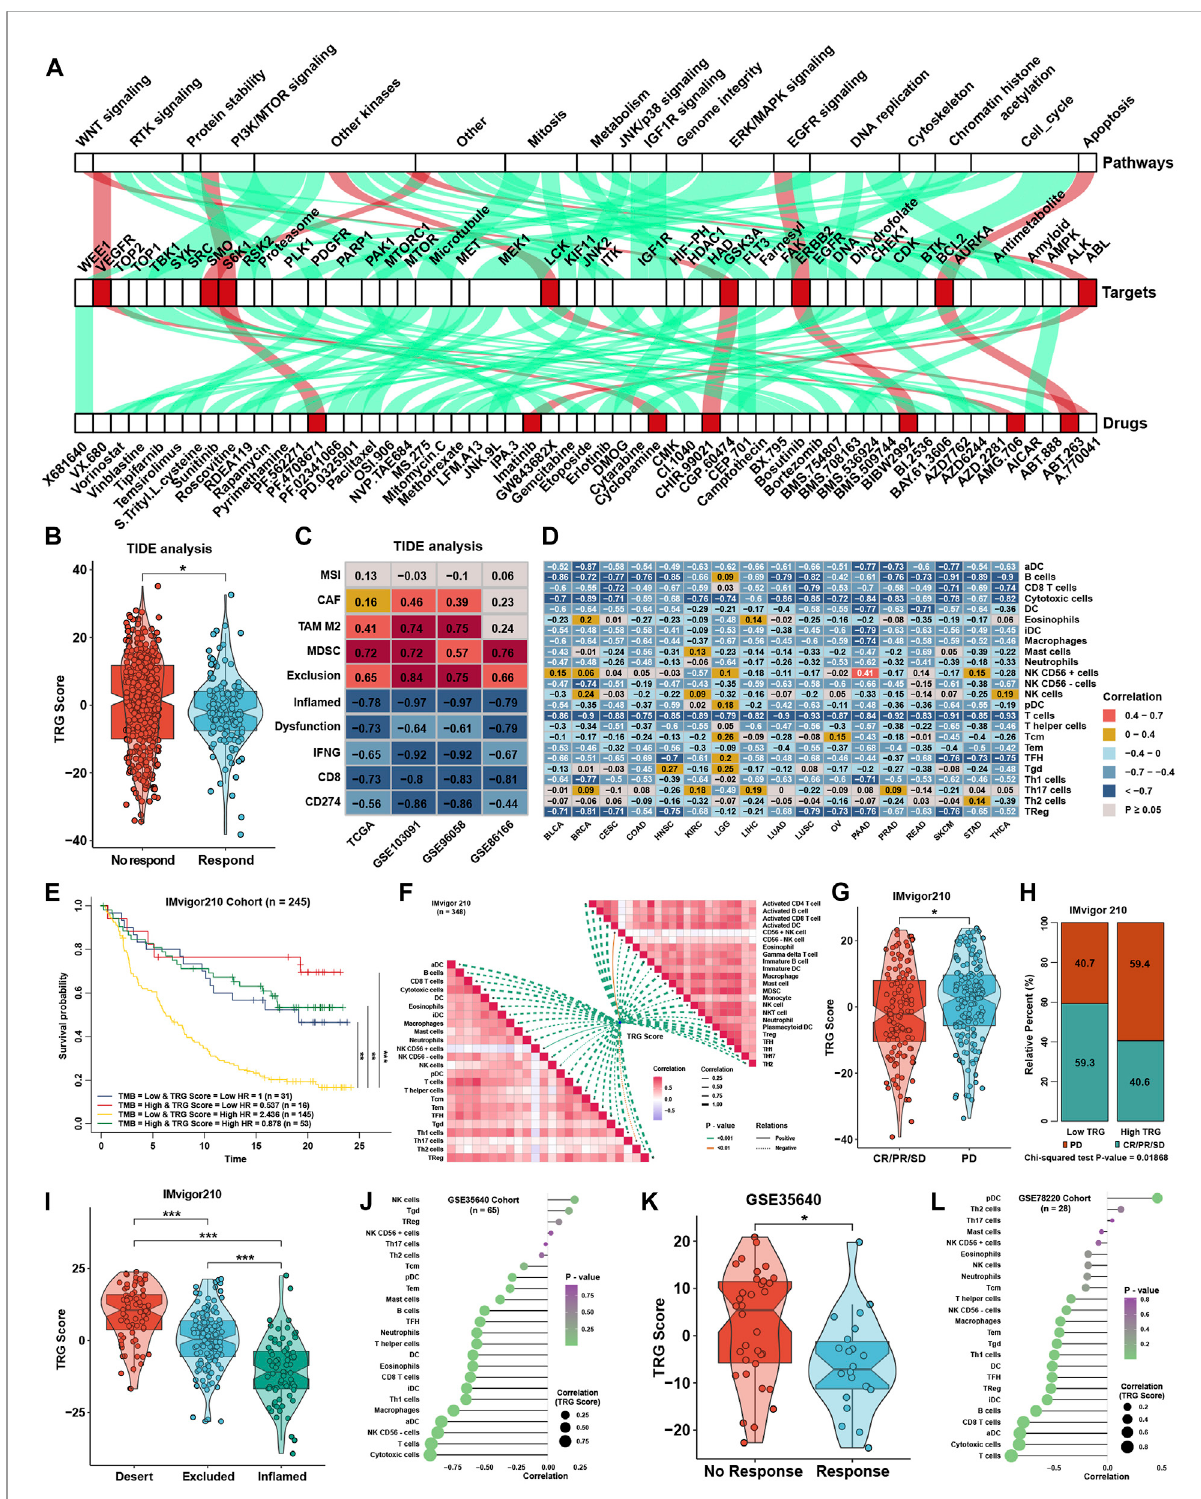
FIGURE 7 RoleoftheTRGscoreintherapeuticef fi cacy. (A) CorrelationanalysisbetweenTRGscoreandpredictionIC50valuesinthewholeTNBCcohort. The green line represents that the predicted IC50 of drugs was positively correlated with the TRG score, and the red line represents a negative correlation. (B) Difference in TRG score between immunotherapy respondents and nonresponders in TIDE analysis in the whole TNBC cohort. (C) Correlation analysis between the TRG score and the results of TIDE analysis in four TNBC cohorts. (D) Correlation analysis between the TRG